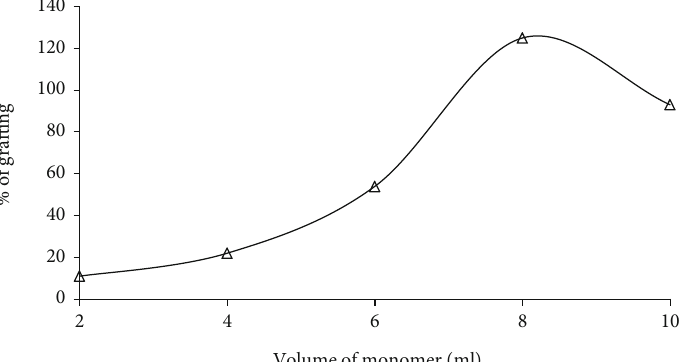
Figure 4: E ff ect of the amount of monomer (AN) on the % of grafting. Reaction time: 60min, H 0.3mmol, and ( Δ ): % of grafting.